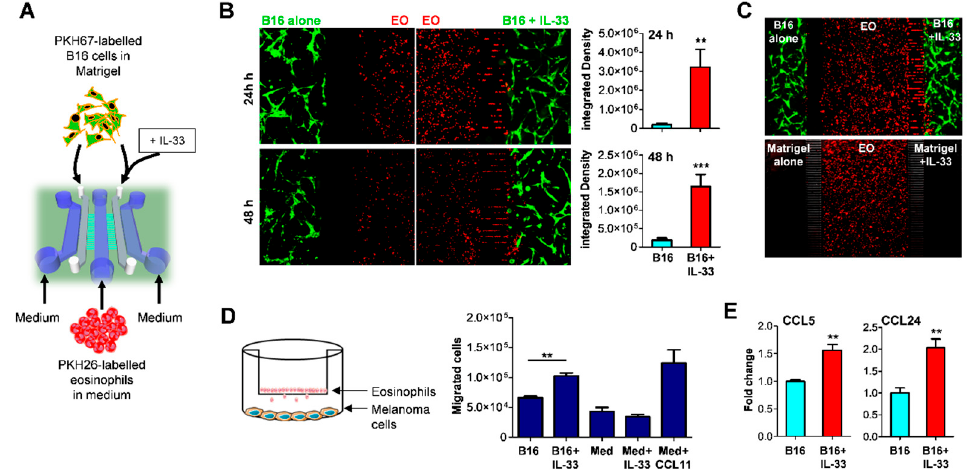
Figure 1. IL-33 recruits eosinophils to the tumor site via indirect mechanisms. ( A ) Schematic view of microfluidic chip employed to monitor the migration of eosinophils towards tumor cells and in response to IL-33 in a competitive setting. B16.F10 melanoma cells were labeled with PKH67 dye (green), embedded in Matrigel with or without the addition of IL-33 and inserted in lateral gel chambers (grey). Eosinophils (EO) were labelled with PKH26 dye (red), resuspended in medium and inserted in the central chamber (blue). The lateral chambers (blue) were filled with medium. Chips were placed in a humidified CO 2 incubator. The migration of EO towards lateral tumor-gel chambers was monitored by fluorescence microscopy. ( B ) Preferential migration of EO (red) towards IL-33-treated B16 tumor cells (green) after 24 and 48 h culture (left) and relative quantitative analysis (right), expressed by integrated density of red fluorescence in the two Matrigel chambers. Mean of several fields ± SD, from 3 replicates. ( C ) EO migrate towards IL-33-treated B16 cells but do not in response to IL-33 alone in a chip. ( D ) Transwell migration assay of EO in response to IL-33 or B16 cells treated with IL-33. CCL11 was used as a positive control. Med, medium. Data show the number of eosinophils migrated to the lower compartment in culture triplicates ± SD. One representative experiment out of two is shown. ( E ) Induction of EO-attracting chemokines CCL5 and CCL4 by IL-33 in B16 melanoma cells, as revealed by qRT-PCR. ** p < 0.01.